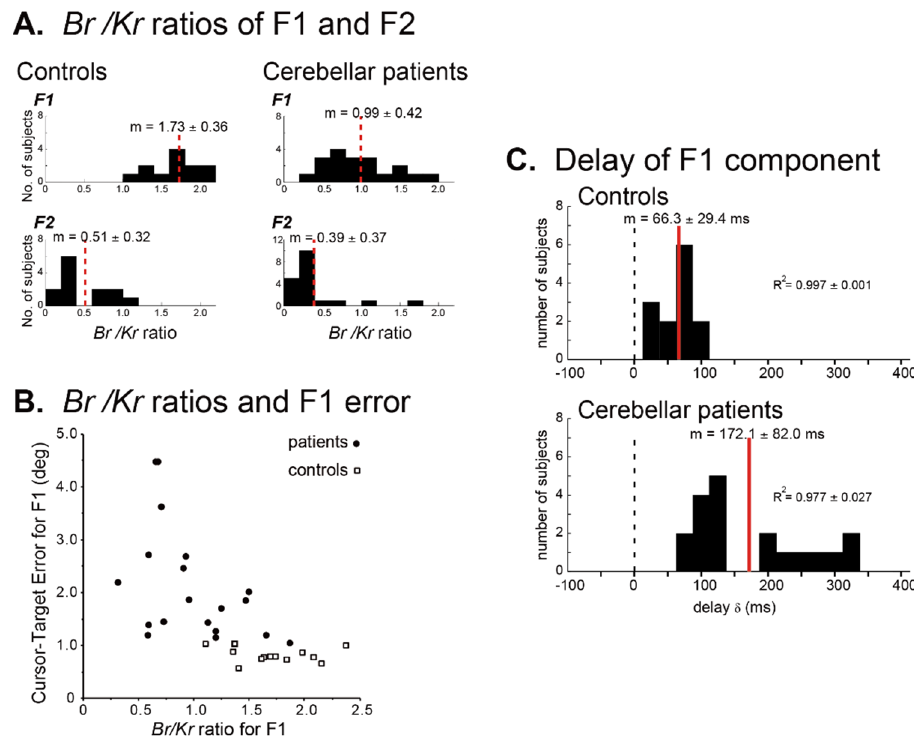
Figure 7. Difference of muscle activities and movement kinematics between controls and cerebellar patients. ( A ) Comparison of the Br/Kr ratios for the F1 and F2 components between the controls and the cerebellar patients. Controls: Br/Kr ratios of the control subjects for the F1 component (top) and the F2 component (bottom) ( n = 13). Note the highly significant difference between the two components. Cerebellar patients: Br/Kr ratios of the patients for the F1 (top) and the F2 (bottom) components ( n = 19). Note the selective decrease of Br/Kr ratios for the F1 component in the patients. ( B ) Correlation between the Br/Kr ratios for F1 component and Cursor-Target error for F1 (F1 error, in short). The Cursor-Target error for F1 (F1 error) is defined as an average error between the target motion and the F1 component of the movement during a trial. Note the negative correlation. ( C ) Delay of the predictive component of the movement (i.e., F1 component) relative to the target motion calculated with a cross-correlation analysis for Controls ( n = 13) and Cerebellar patients ( n = 19).